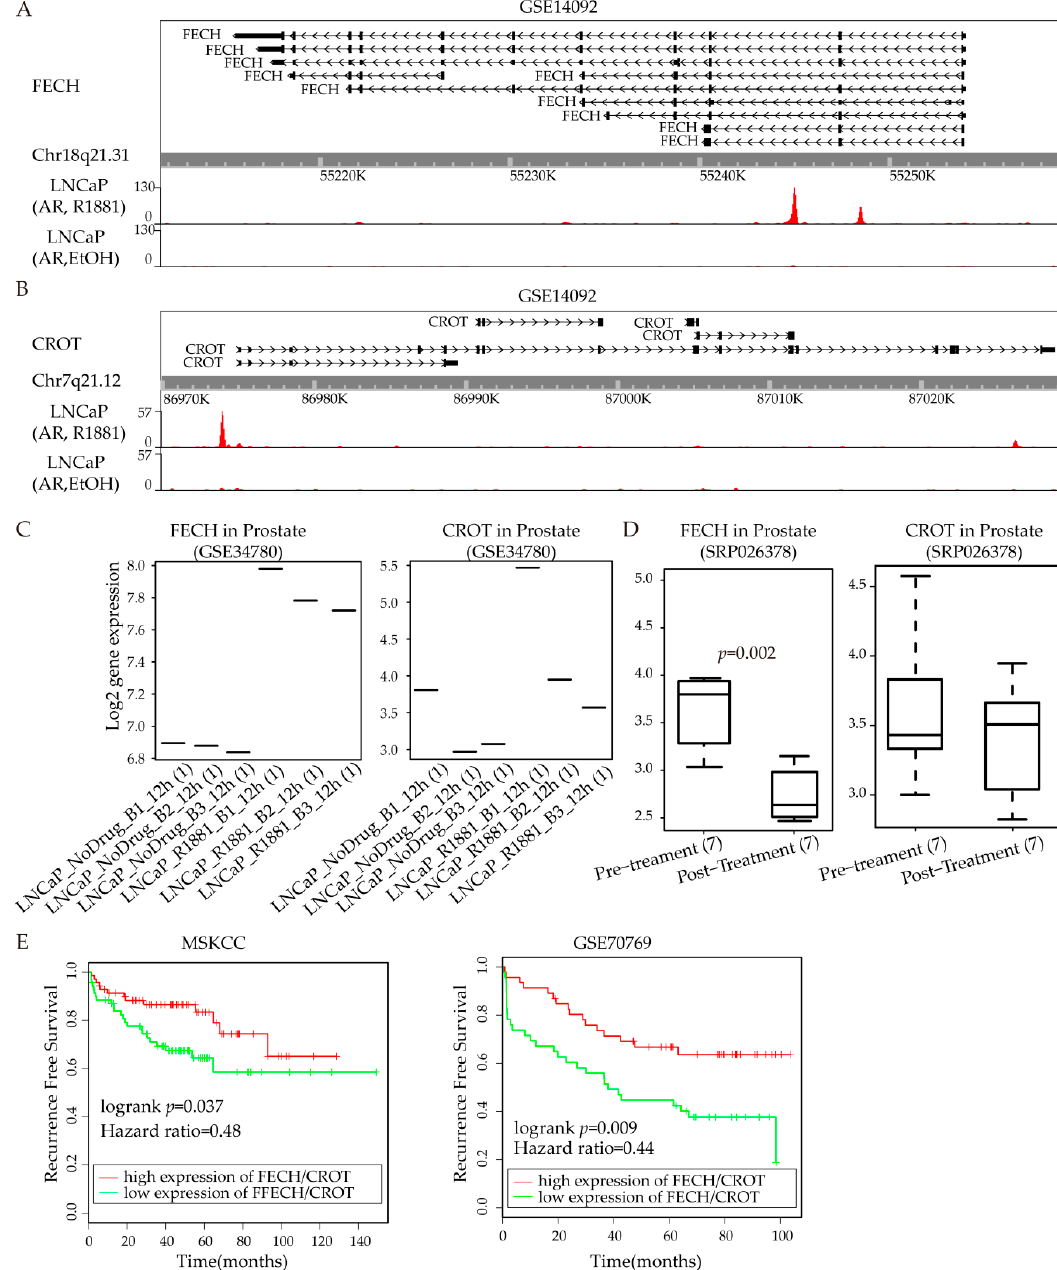
Figure 6. FECH and CROT are potent prognostic markers regulated by AR. ( A ) FECH has AR binding sites (ARBS) from public ChIP-seq dataset (GSE14092); ( B ) CROT has ARBS from public ChIP-seq dataset (GSE14092); ( C ) Expression of FECH and CROT before and after R1881 stimulation in LNCaP cells (GSE34780); ( D ) FECH and CROT expression after androgen ablation therapy (AAT) in prostate cancer patients (SPR026378); ( E ) FECH / CROT signature is a potent prognostic marker of prostate cancer based on survival analysis of the MSKCC dataset (left) and GSE70769